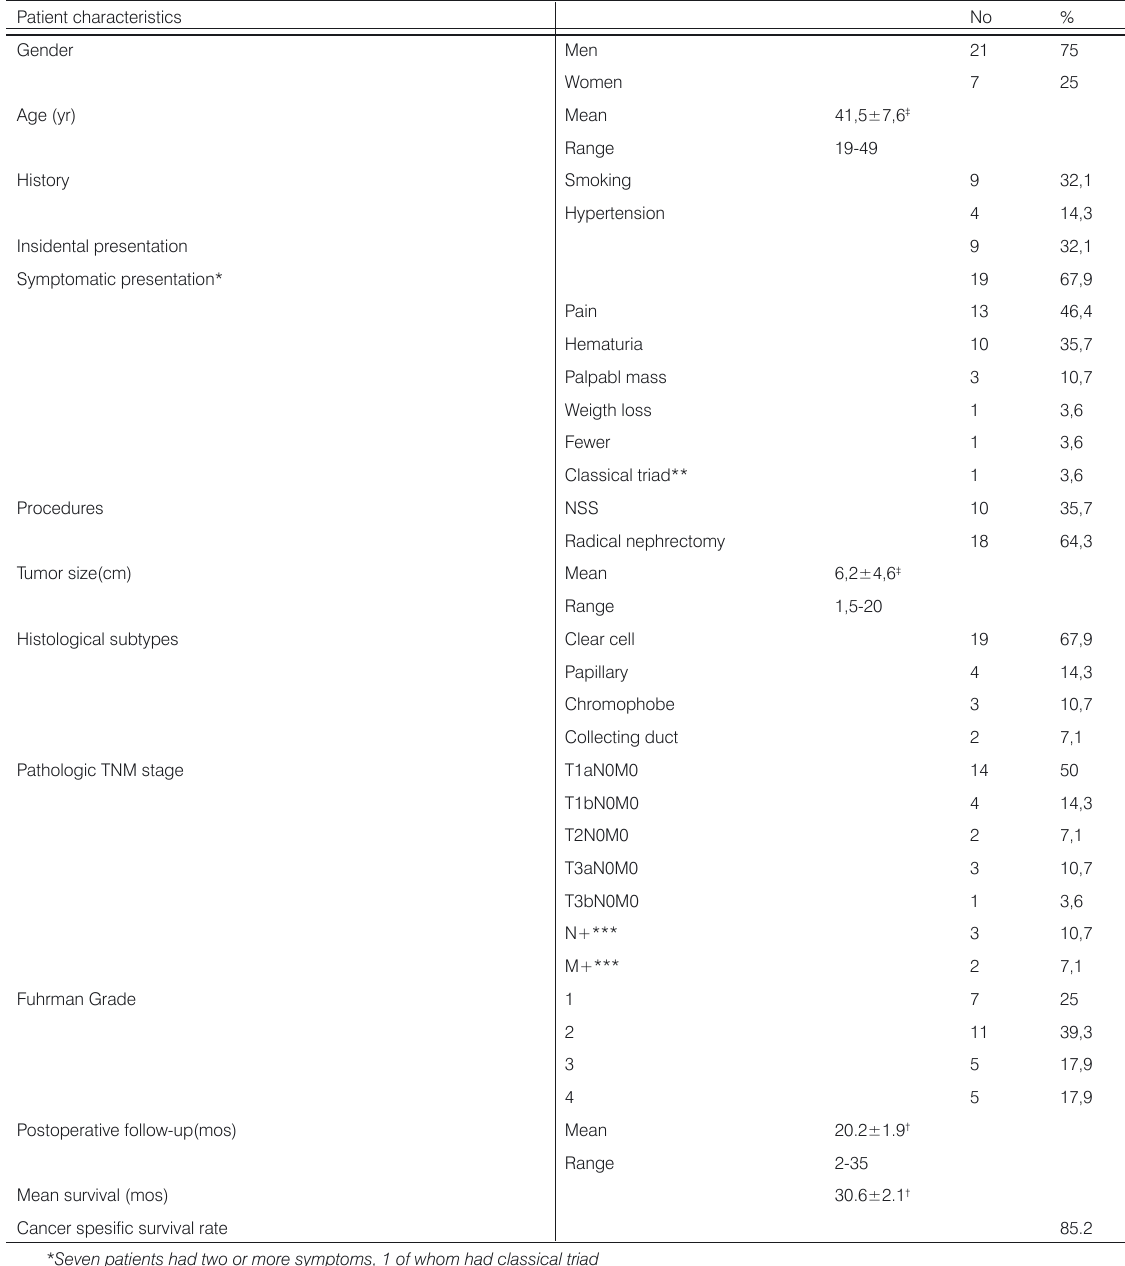
Table 1. Patient characteristics, surgical procedures and